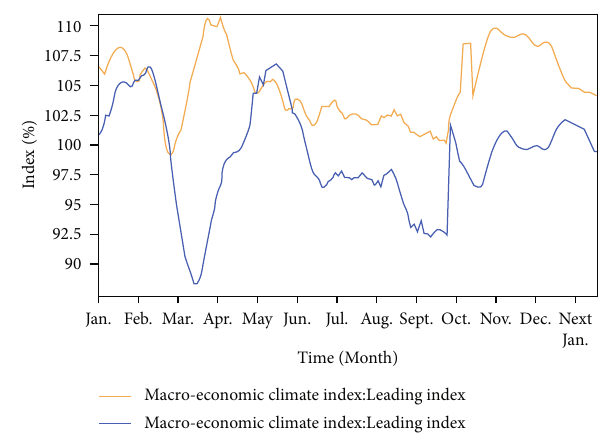
Figure 3: Monthly data fl uctuations of leading and lagging